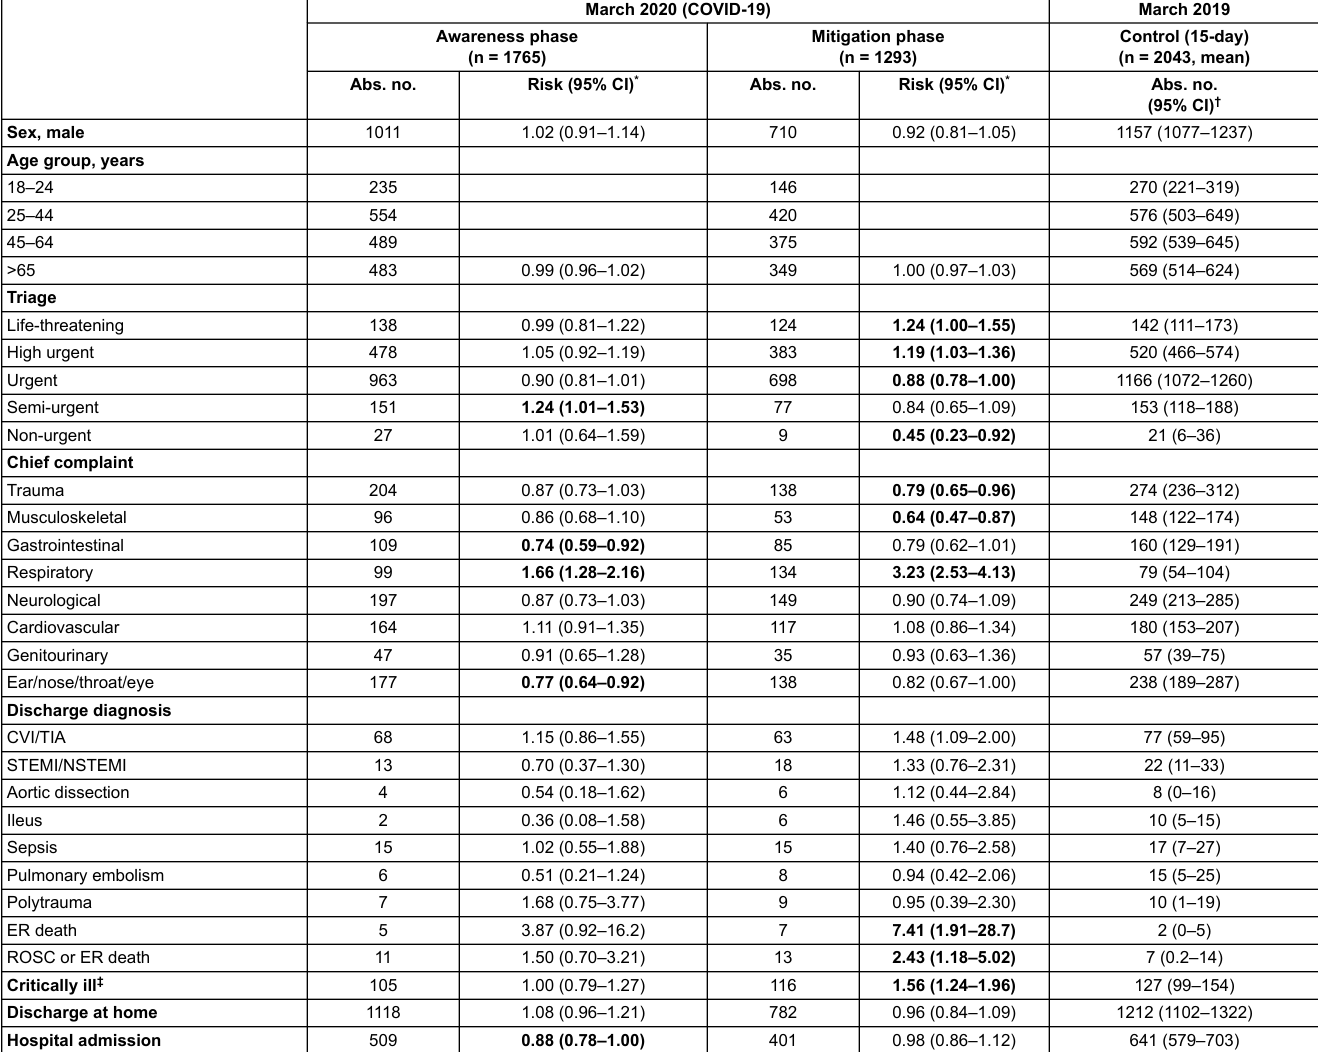
Table 1: Patient characteristics by period, compared with the control